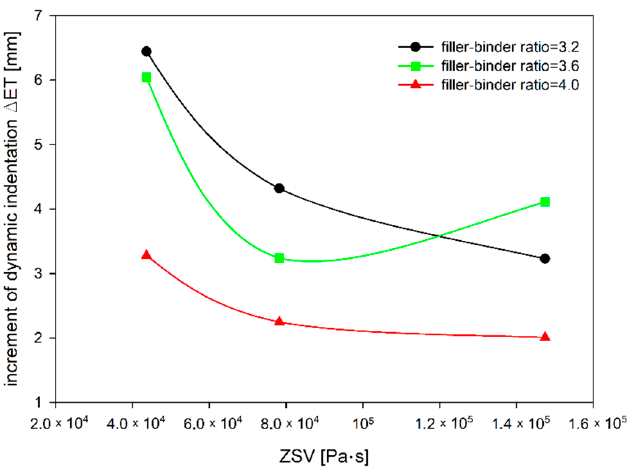
Figure 15. The dependence of increment of MA dynamic indentation on ZSV of TLA-modified binder for different filler–binder ratios.